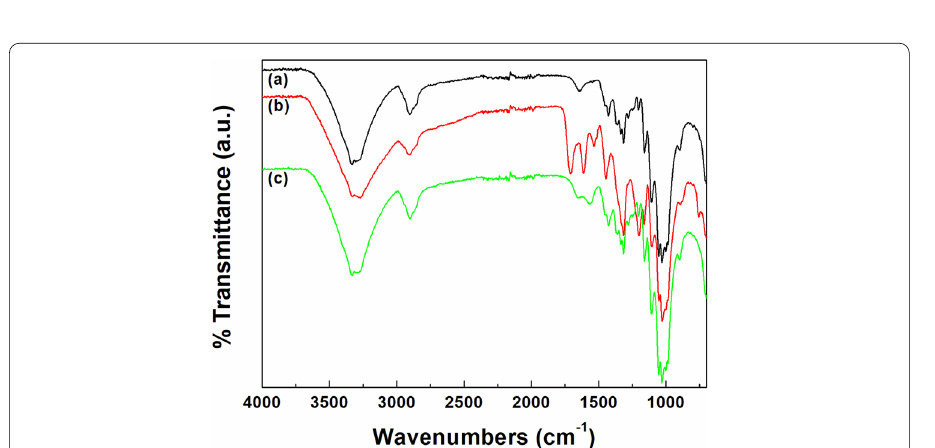
500 in top row, 1500 bottom row) × ×